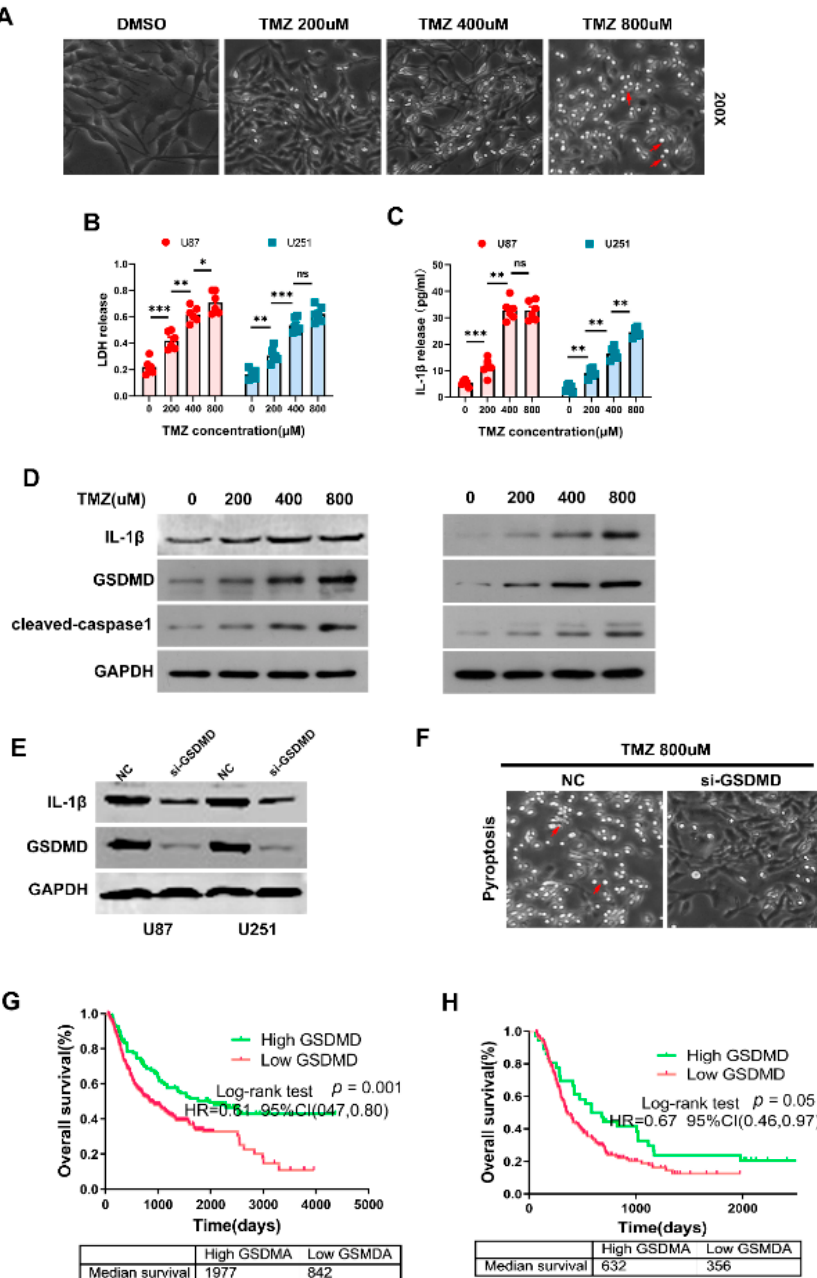
Figure 8. GSDMD mediated TMZ-induced pyroptosis in glioma. ( A ) Morphological changes in U251 cells treated with different concentrations of TMZ. Cells presented with large bubbles emerging from the plasma membrane (red arrows). ( B , C ) ELISA kits were used to measure the level of LDH and IL-1 β after treatment with TMZ. * p < 0.05. ** p < 0.01. *** p < 0.001. ns, no significance. ( D ) Expression of GSDMD, cleaved caspase 1 and IL-1 β were detected using WB in U251 and U87 cells treated with TMZ. GAPDH was used as internal reference. ( E , F ) After transfection of siRNA against GSDMD, the expression of GSDMD and IL-1 β were examined by WB. Morphological changes were observed (red arrows). ( G , H ) Prognostic role of GSDMD in predicting TMZ response in glioma patients in CGGA. HR, hazard ratio.